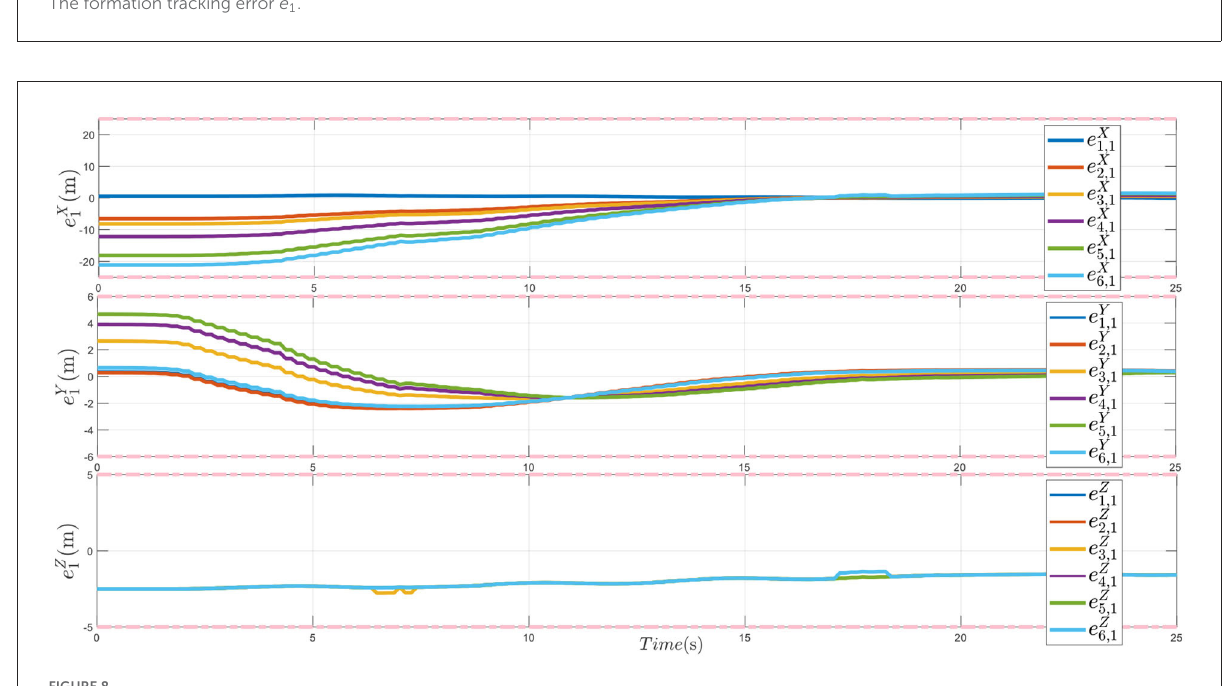
FIGURE8 The formation tracking error e 1 without applying PTPF